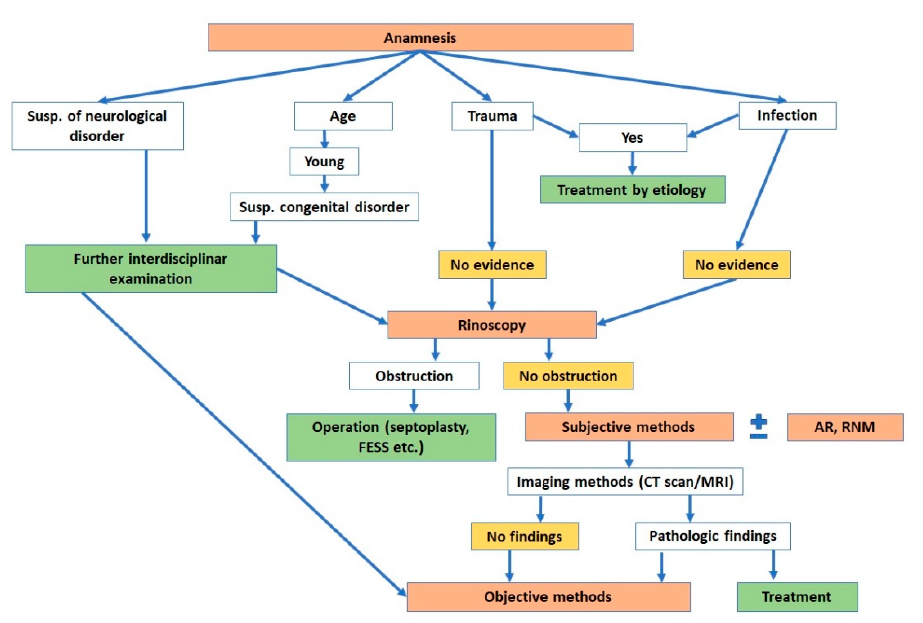
Figure 10. Our strategy for the indication of olfactory tests.